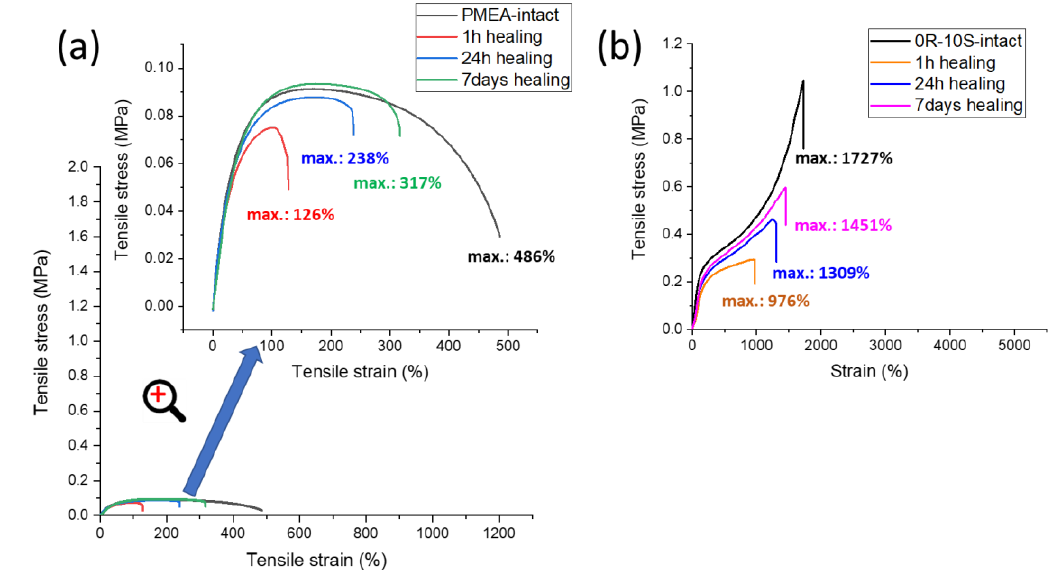
Figure 10. Self-healing of clay-free polyMEA-based super-elastomers tested by means of tensile experiments: ( a ) neat polyMEA; ( b ) poly(MEA-co-10%SMA).